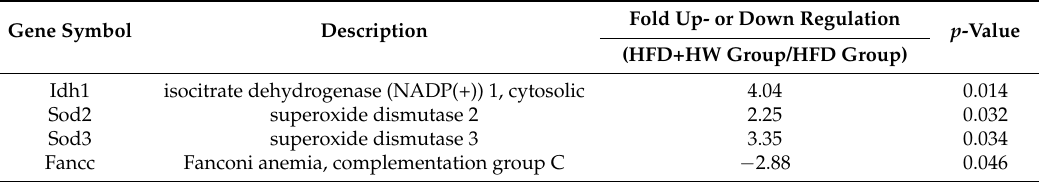
Table 3. Differentially expressed genes involved in oxidative stress of gingival tissue between the HFD group and the HFD + HW